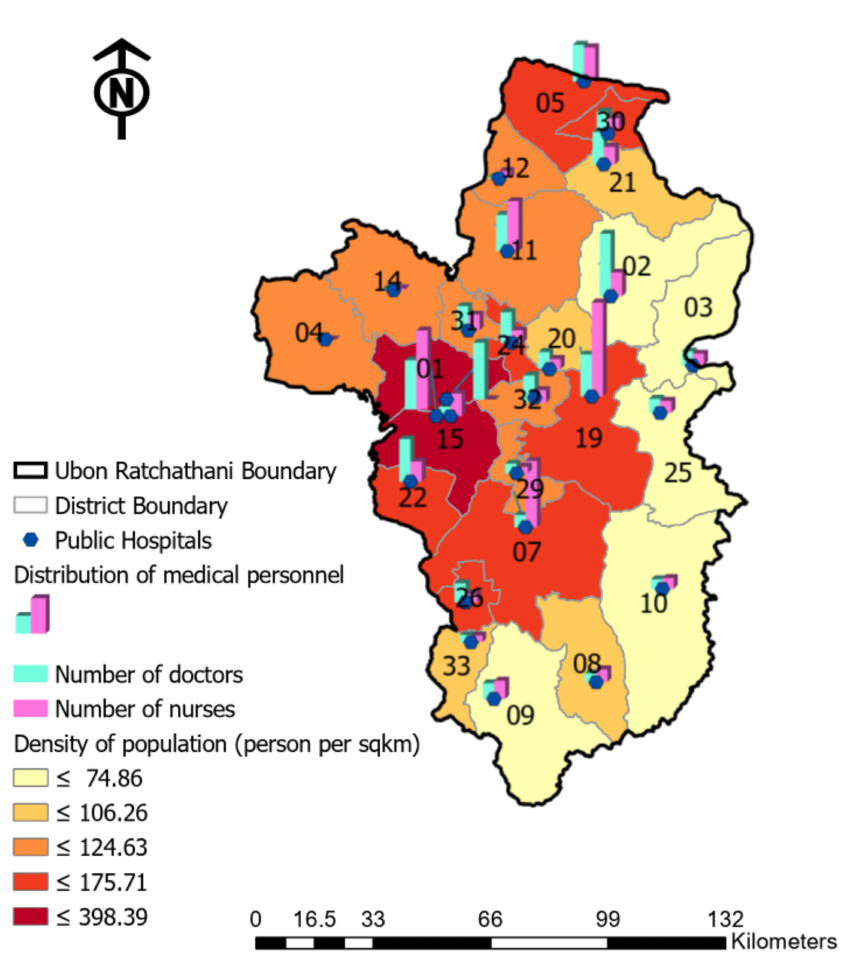
Figure 5. Spatial distribution of physicians and the population density within the study